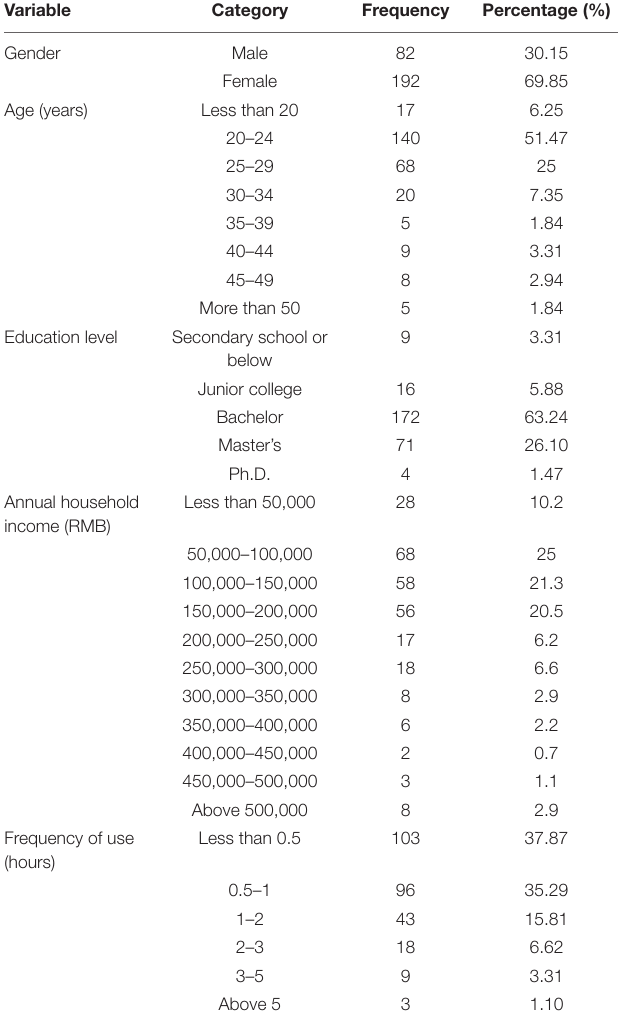
TABLE 1 | Descriptive statistics of the study